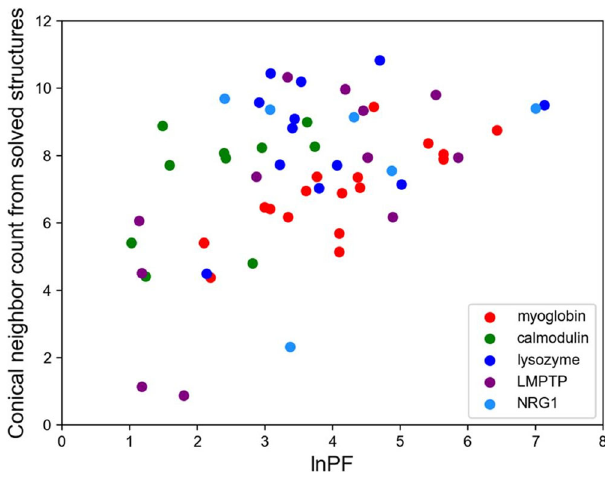
Fig. 3 Correlation between HR-HRPF lnPF and conical neighbor count. The correlation measured for NRG1 performed blinded to the NMR structure (cyan) was consistent with those reported for proteins of known structure (red: myoglobin; green: calmodulin; blue: lysozyme; violet: